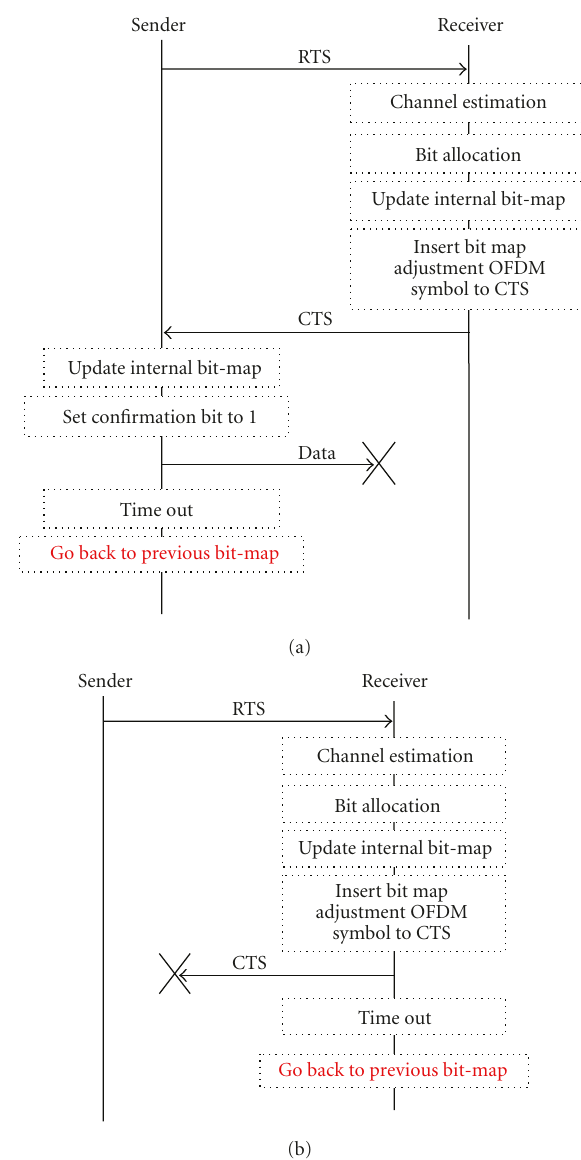
Figure 7: Protocol operation in cases of (a) Data loss and (b) CTS